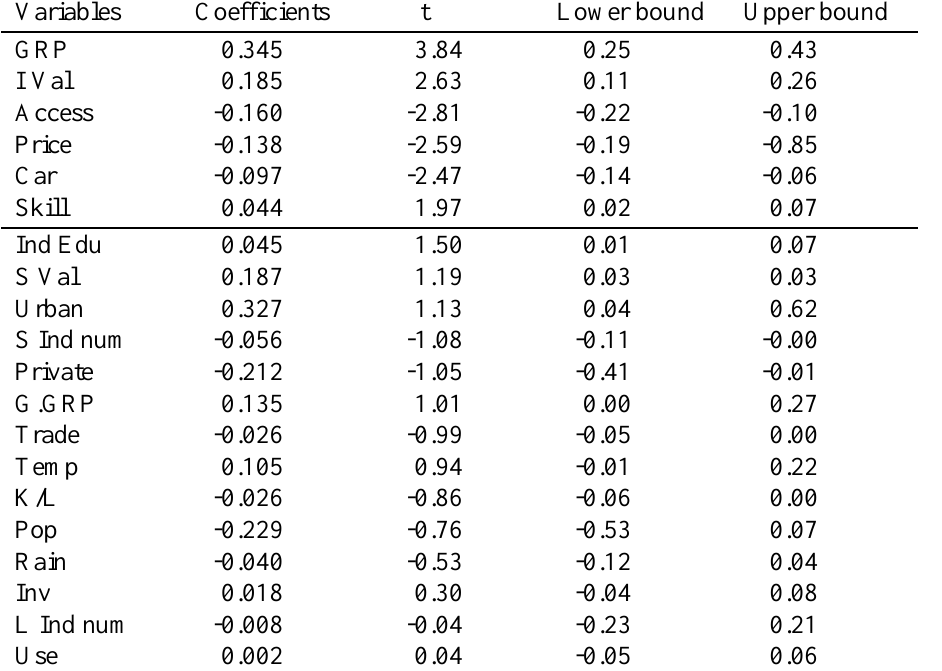
Table 3. Results of WALS estimation Variables